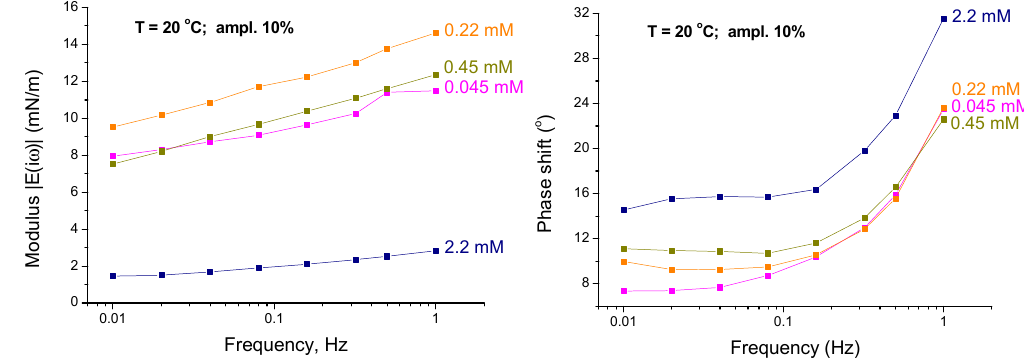
Figure 4. Viscoelasticity modulus | E ( i ω ) | and phase shift ϕ ( ω ) as functions of frequency for TTAB concentrations of 4.5 × 10 − 5 , 2.2 × 10 − 4 , 4.5 × 10 − 4 and 2.2 × 10 − 3 mol/dm 3 (injections 6-1 to 6-4) at a fixed C 13 DMPO concentration of 2.2 × 10 − 5 mol/dm 3 (T = 20 °C; ampl. 10%); the lines are guides for the eye.